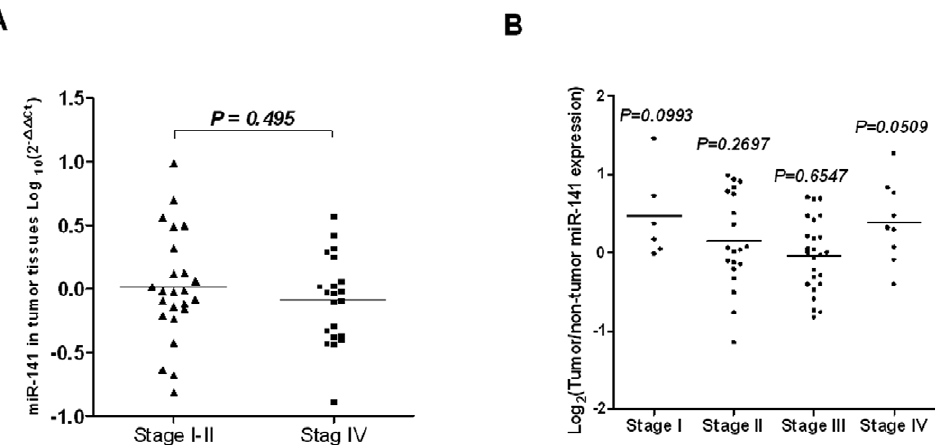
Figure 5. MiR-141 in tumor tissues is not associated with colon cancer tumor stage. (A) Total RNA was isolated from tumor tissues of metastatic or non-metastatic patients from the Tianjin cohort, and the miR-141 levels were measured with quantitative RT-PCR using RNU6B as an endogenous control. The Wilcoxon two-sample test was performed to compare miR-141 expression in tumor tissues between these two groups. A P , 0.05 is considered significant. (B) The miR-141 expression levels were measured using microRNA profiling data from the Maryland cohort of CRC samples. The Wilcoxon matched-pairs tests were performed to compare the miR-141 levels between tumor tissues and adjacent normal tissues in these CRC